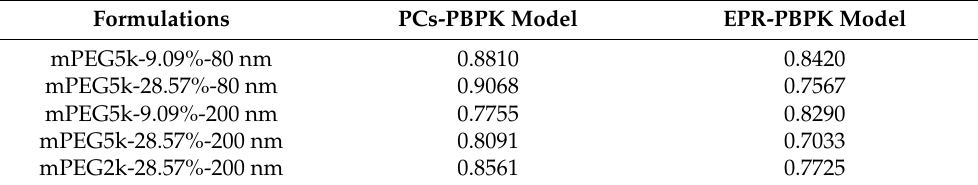
Table 1. Goodness of fit for physiologically based pharmacokinetic (PBPK) model of NP formulations (R 2 ). PCs: phagocytic cells; EPR: enhanced permeability and retention.